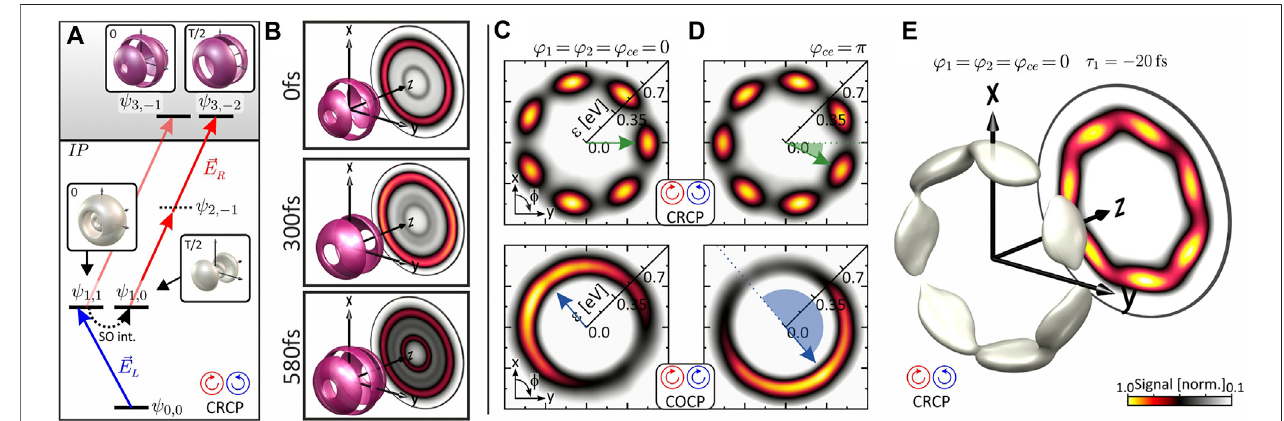
FIGURE 10 | Applications of intra- and interband interference in the MPI of potassium and sodium atoms using circularly polarized bichromatic pulse sequences. (A) Excitation scheme for the time-resolved 3D imaging of ultrafast SOWP dynamics in potassium using shaper-generated bichromatic pump-probe pulse sequences. (B) Reconstructed 3D PMDs for different stages of the SOWP cycle, revealing the orbital realignment dynamics in the excited 4 p state due to the spin-orbit interaction. (C) and (D) Coherentcontroloftheazimuthalrotationofthe c 1 and c 7 rotationallysymmetricFEVsfrom Figures9B,C ,respectively. (E) Reconstructed3DPMDofa seven-arm Archimedean spiral-shaped FEV created by MPI of sodium using a time-delayed ( τ 1 (cid:2) − 20 fs) CRCP (3 ω :4 ω ) bichromatic pulse